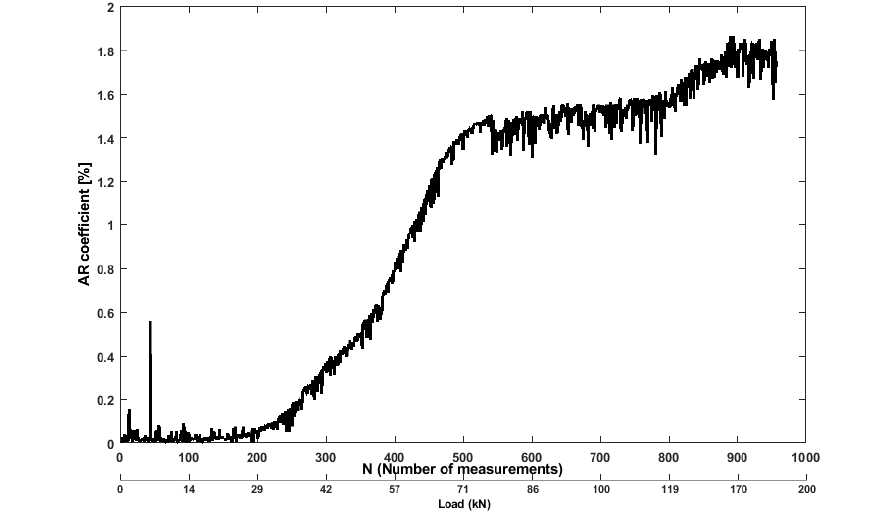
Figure 14. Values of AR residual error feature from ultrasonic pair S01R04 time